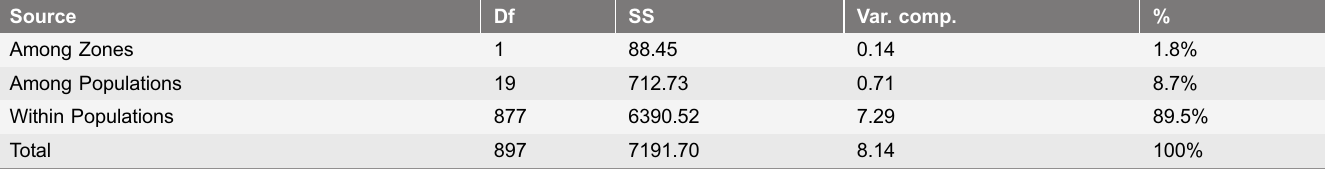
To illustrate genetic relationships of the 21 Sri Lankan weedy rice populations across the country, a UPGMA dendrogram (Figure 2) was constructed based on the cluster analysis of the genetic similarity matrix generated from SSR genotyping of these populations. The two groups of nine rice varieties and 15 wild rice ( O. nivara ) accessions were included in the cluster analysis as references. The results of